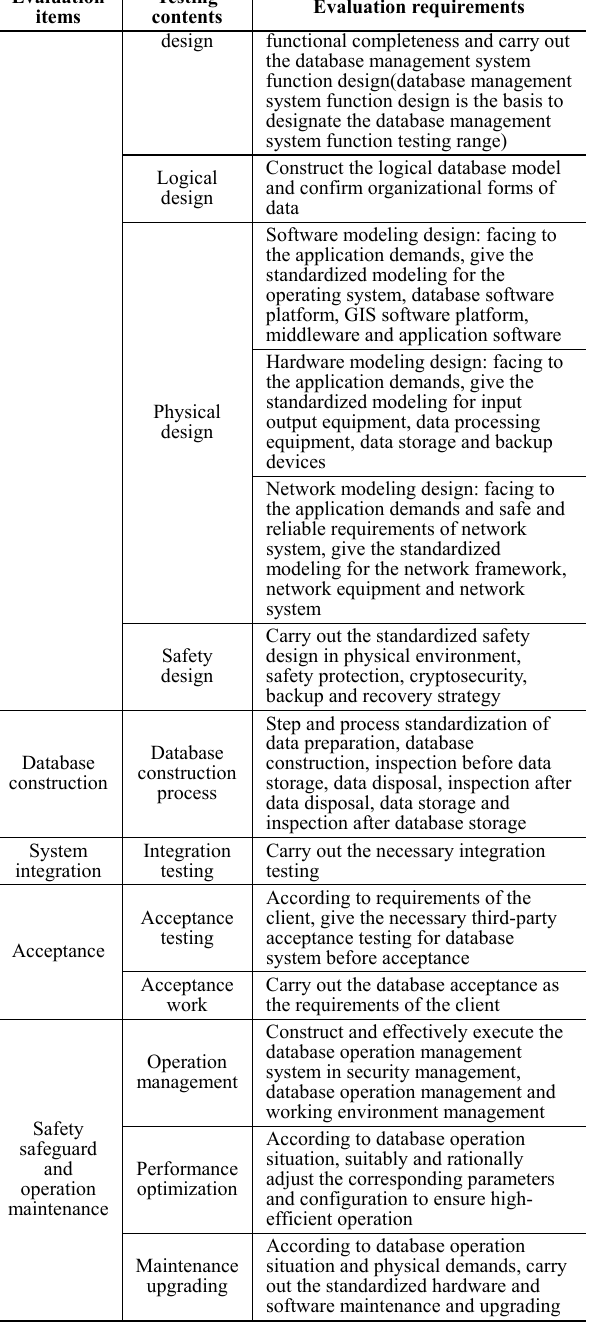
Table 1. The Testing Evaluation Ranges and Requirements of Database Construction and Quality